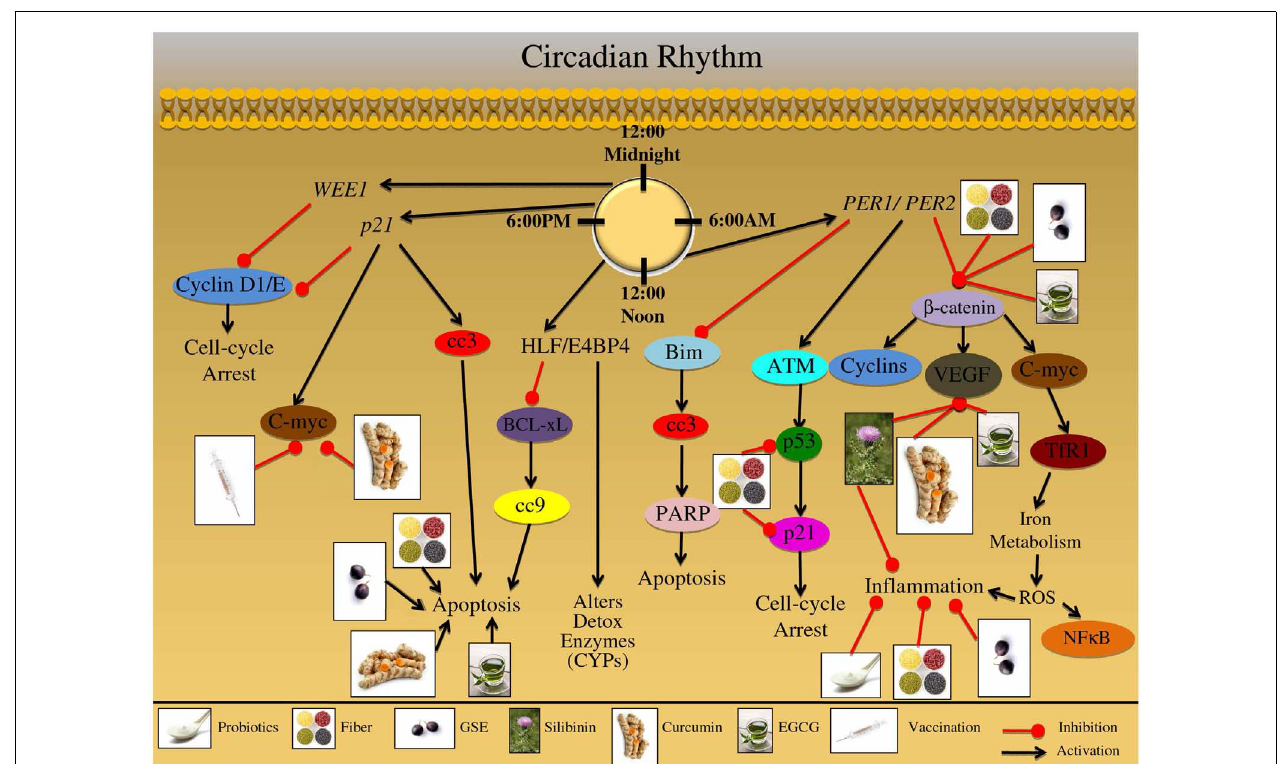
FIGURE 5 | Effect of circadian rhythm on growth and development of colon carcinogenesis. The mammalian circadian clock takes 24h to complete and is a self-sustaining feedback loop of core clock genes.This group of clock genes regulate various cellular processes including: detoxification; DNA repair; proliferation; cell cycle regulation; apoptosis; metastatic signaling, and inflammation. Furthermore, these cellular processes are then regulated in a time specific manner; disruption of this circadian rhythm results in abnormalities in these processes, which contribute to colorectal cancer (CRC) development.The major genes regulating this 24h timekeeping are PER1 and PER2 ; these genes modulate proliferative, apoptotic, inflammatory, and metastatic signaling.These genes have been shown to alter the expression of β -catenin; this protein is involved in proliferation and cell cycle